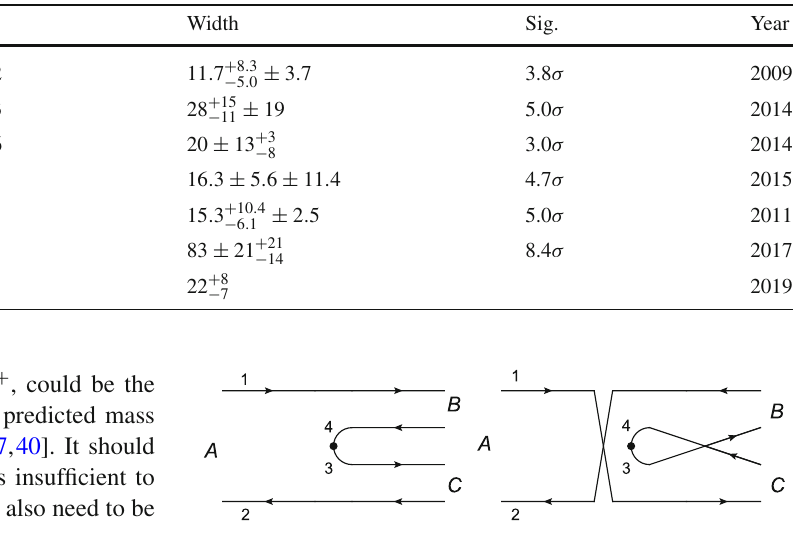
Fig. 1 The two possible diagrams contributing to A → BC in the 3 P 0 model: (left) the quark within the meson A combines with the created antiquark to form the meson B , the antiquark within the meson A combines with the created quark to form the meson C ; (right) the quark within the meson A combines with the created antiquark to form the meson C , the antiquark within the meson A combines with the created quark to form the meson B